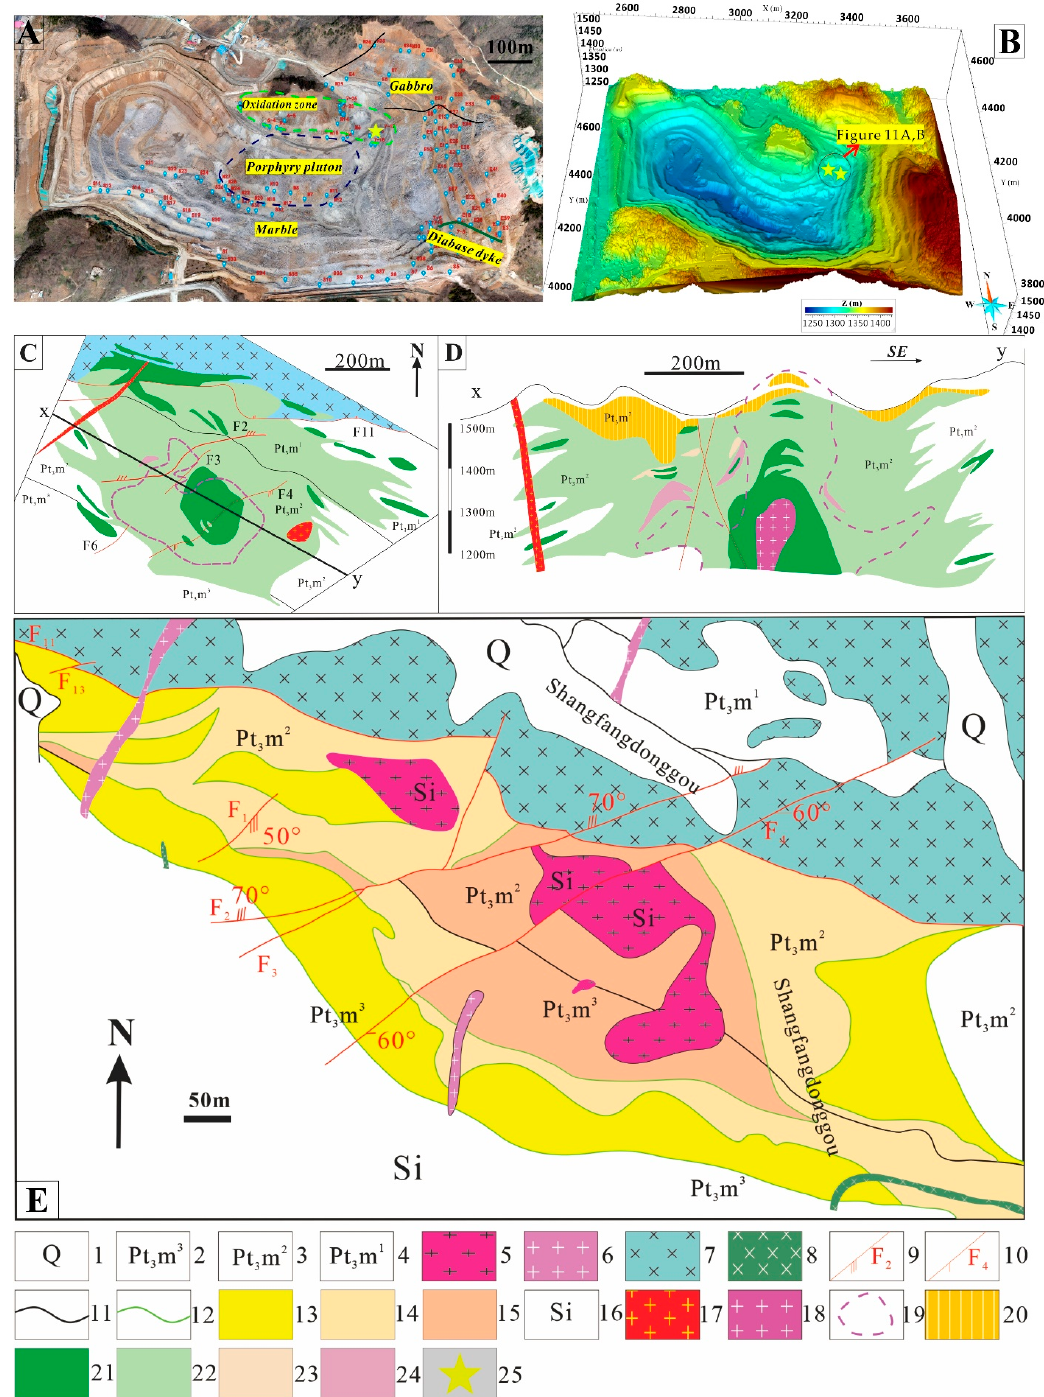
Figure 2. Geological sketch and location of Shangfanggou Mo–Fe deposit: ( A ) the open pit (red points, sample spots collected and analyzed in the fieldwork); ( B ) DEM of the mine; ( C , D ) geologic profile of the deposit, showing the Mo oxide orebodies and geology at 1132 m level and prospecting line NO. 5 (modified after [22,23,40–42]); ( E ) geological map of the deposit (after